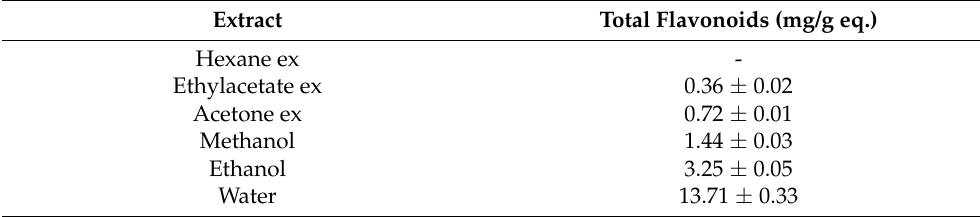
Table 5. Total flavonoids of Ilex x Wandoensis C. F. Miller.